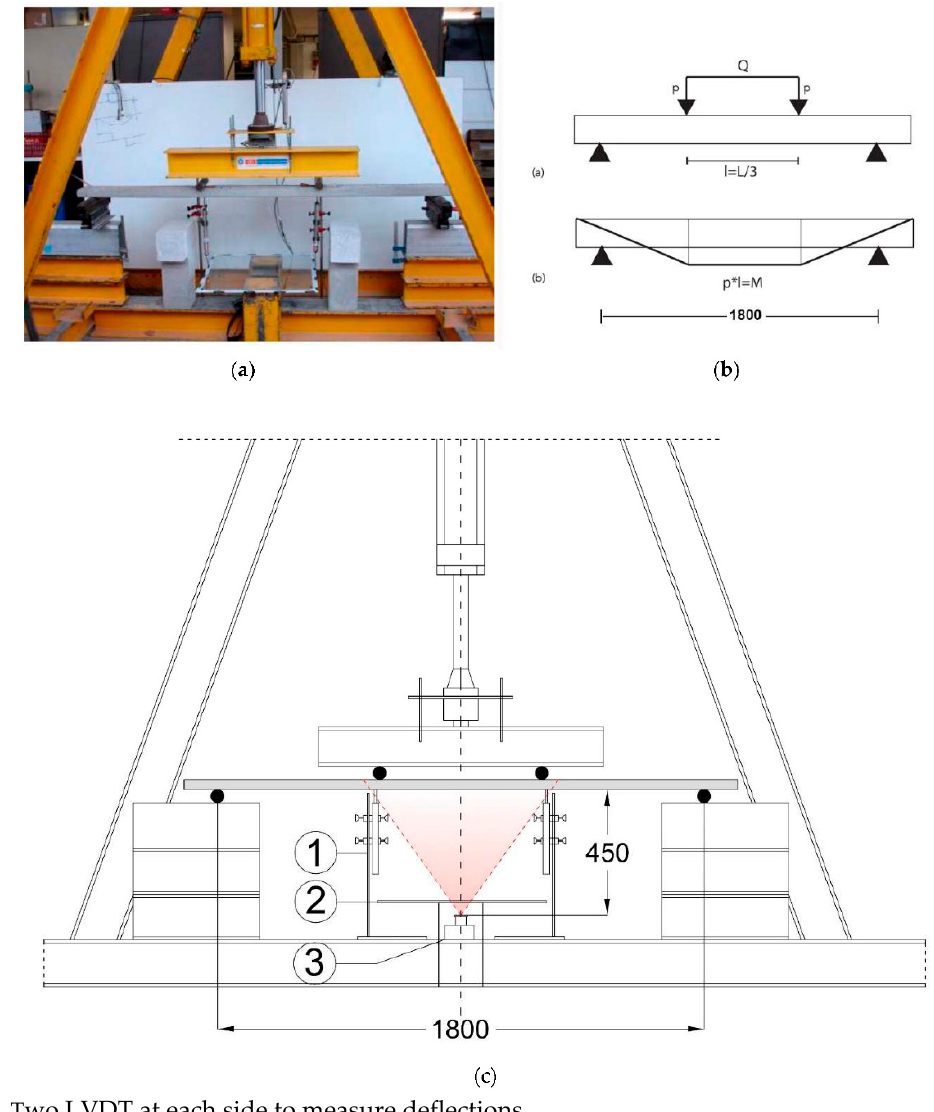
Figure 6. Features of the test: ( a ) general view of the procedure; ( b ) theoretical analysis of the test; and ( c ) displacement control and location of the camera